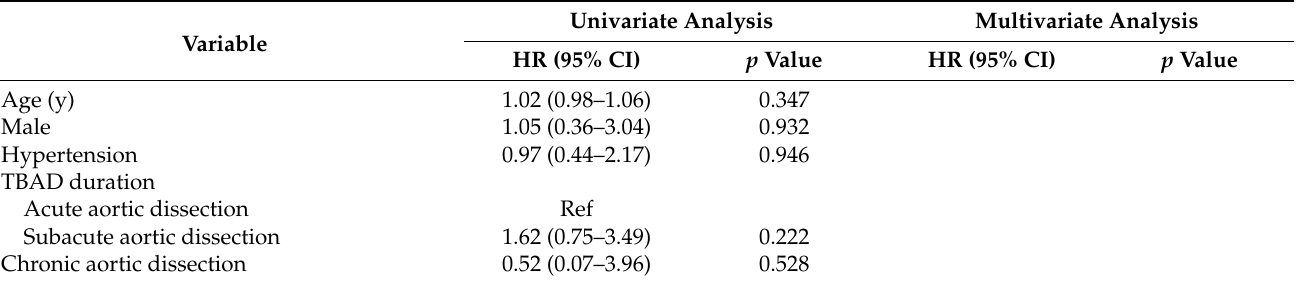
Figure 3. Kaplan–Meier curves of overall survival in patients with or without reintervention after TEVAR. Table 5. Univariate and multivariate Cox hazard analysis of